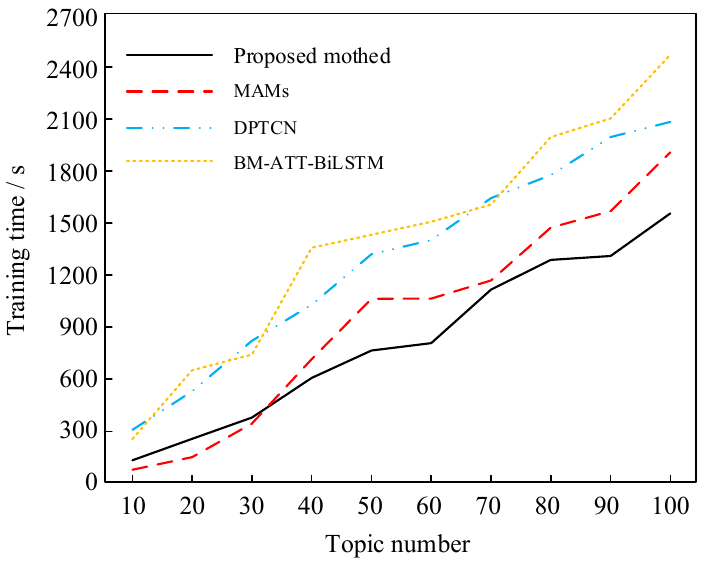
Figure 12. Training time of different methods under SNs dataset.